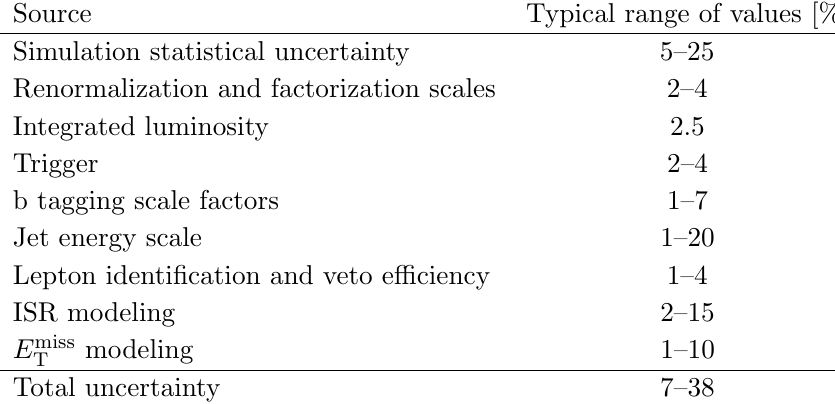
vs. m . The color e t e (cid:31) 0 1